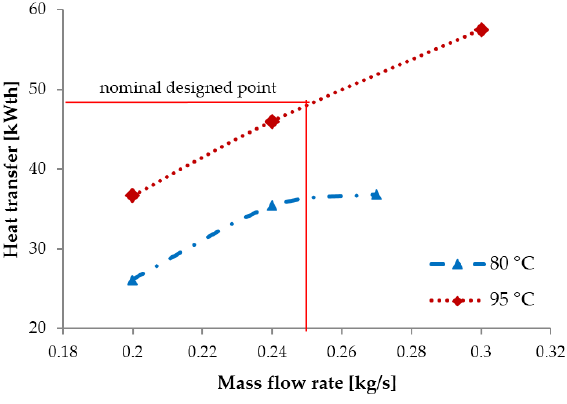
Figure 6. Heat transfer on organic fluid side at different pressure and mass flow rates of 80 °C and 95